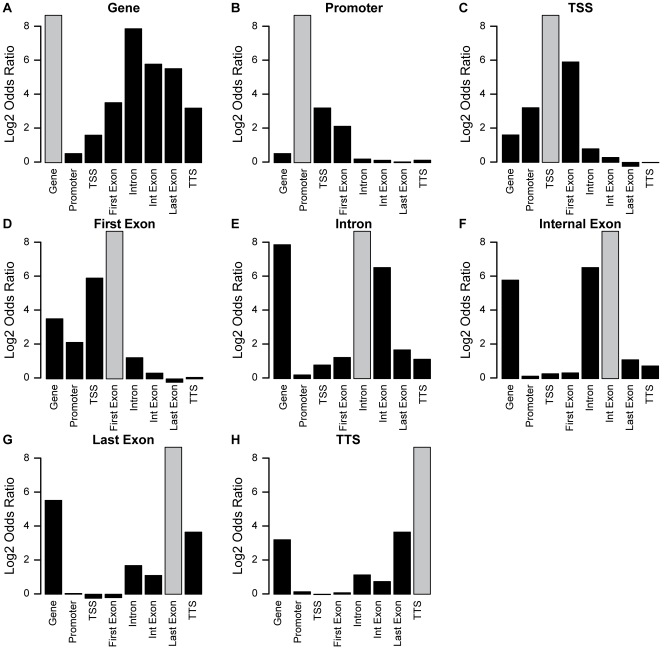
Patterns of gene cassette methylation in T cells.Each gene cassette element was classified as unmethylated (lowest 10% methylation quantile) or methylated (top 90% methylation quantile). The odds ratio (log2 transformed) indicates the likelihood of an element being methylated if the gene body (A), promoter (B), TSS (C), first exon (D), any intron (E), any internal exon (F), last exon (G) or TTS (H) is methylated. Odds ratios, calculated using Fisher's exact test for count data, represent a conditional maximum likelihood estimate quantifying the strength of the correlation between methylation of each gene cassette element. The odds ratio for the autocorrelation of each element is infinite and represented by grey boxes. Representative data is shown for human blood T cells but the pattern is the same in granulocytes and AML cells.